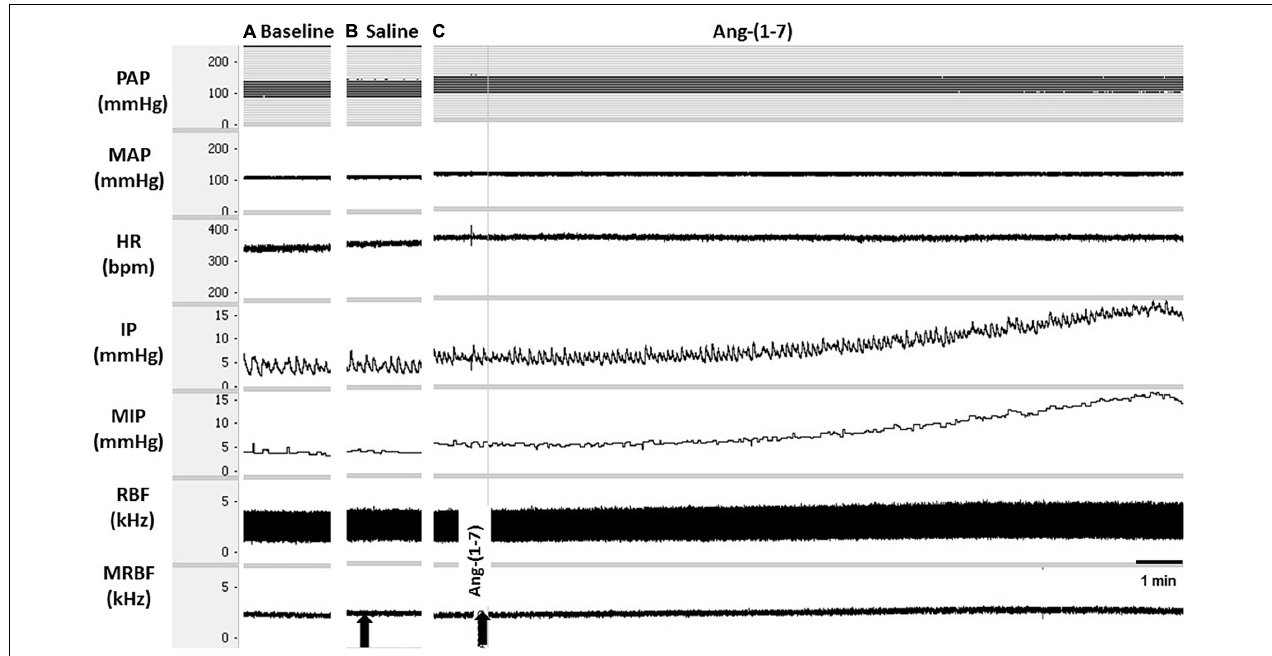
FIGURE 3 | Tracings showing (A) the baseline pulsatile arterial pressure (PAP, mmHg), mean arterial pressure (MAP, mmHg), heart rate (HR, bpm), intravesical pressure (IP, mmHg), mean intravesical pressure (MIP, mmHg), renal blood flow (RBF, kHz), and mean renal blood flow (MRBF, kHz), and the responses evoked by (B) unilateral injection of saline (vehicle, 1 µ L) or (C) angiotensin-(1–7) [Ang(1–7)] (5 nmol/ µ L, 1 µ L) into the lateral preoptic area (LPA). Arrows indicate the moment of saline or Ang-(1–7) injection into the LPA.